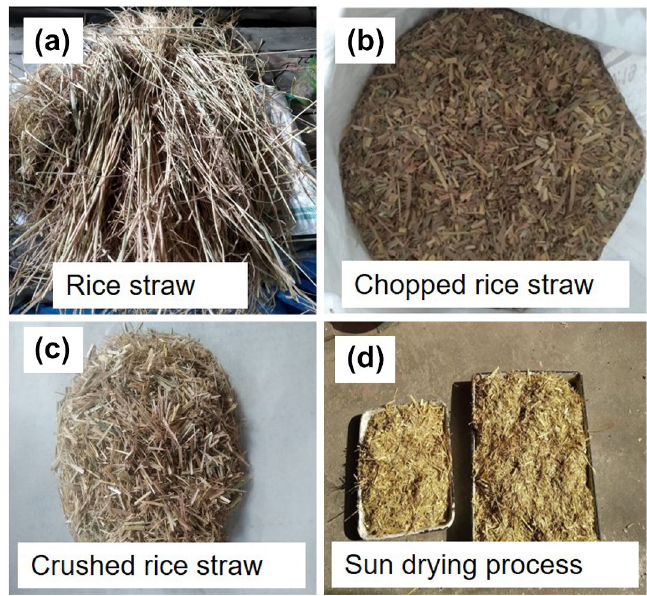
Figure 1. ( a ) Collected rice straws from farm fields; ( b ), ( c ) chopped and crushed rice straw; and ( d ) sun drying process for moisture removal.